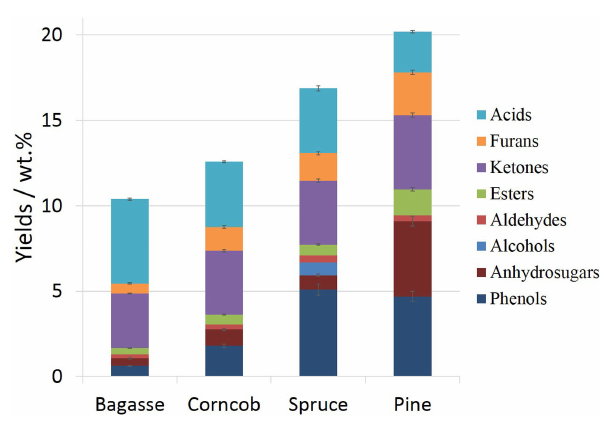
FigUre 2 | chemical composition of bio-oils from different feedstock pyrolysis .